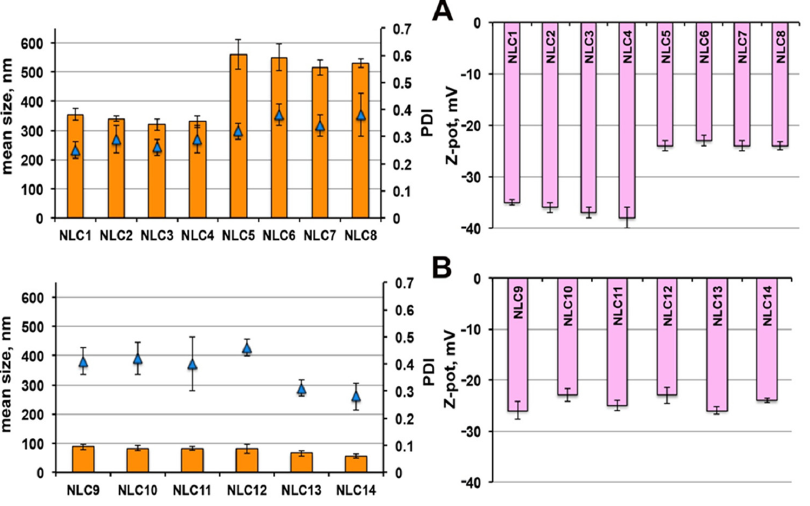
Figure 2. Physicochemical properties of empty NLCs in terms of mean size, polydispersity index (PDI) and Zeta potential: NLC 1 -NLC 8 ( A ); NLC 9 -NLC 14 ( B ). See Table 3 for their composition.